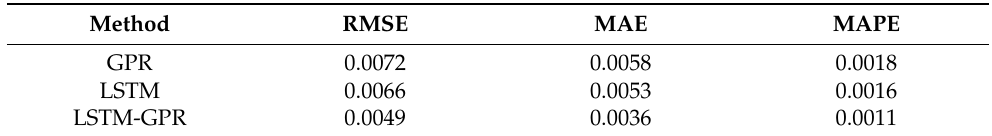
Table 2. Comparison of the prediction results of the proposed method with individual model methods.